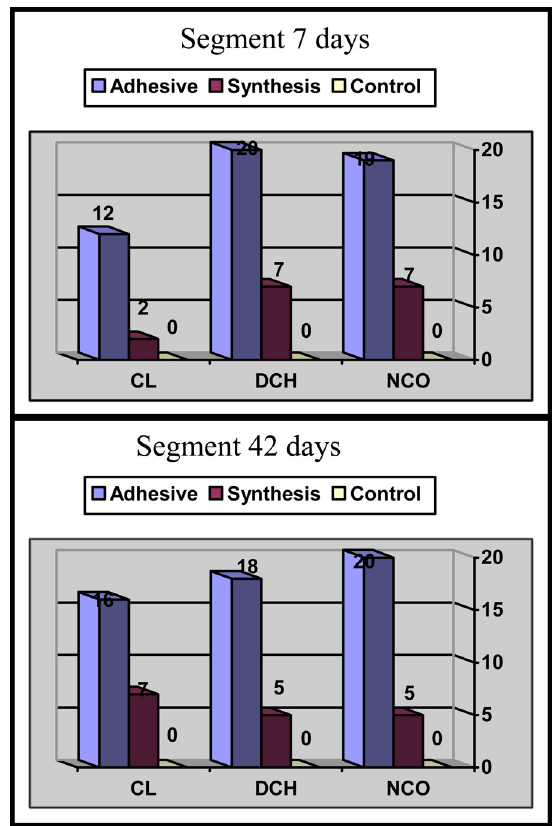
FIGURE 5 - C L = free body, D C H = degeneration of the cartilage hyaline, N C THE = it necroses of the cartilage hyaline /osso subchondral.